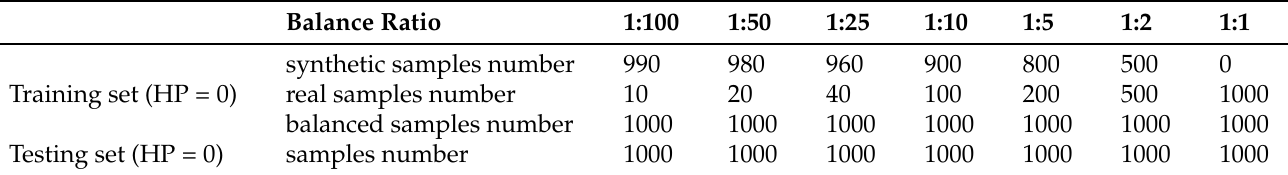
Table 4. The data set partitioning of the of imbalance fault diagnosis for each